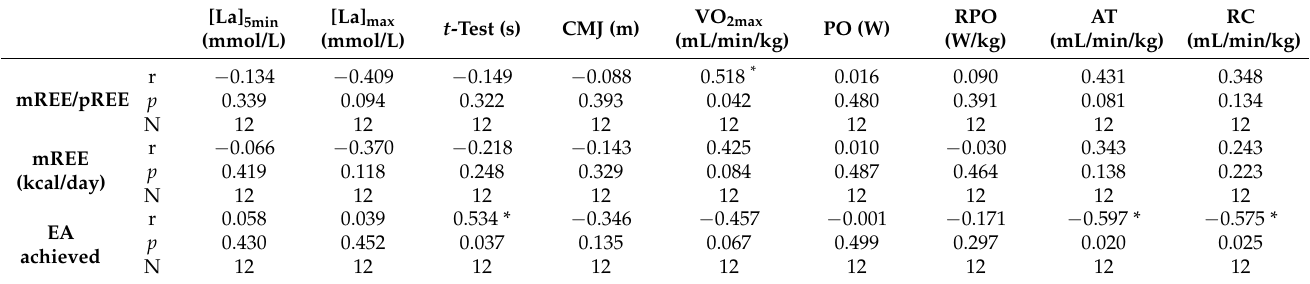
Table 4. Correlations of energy parameters with